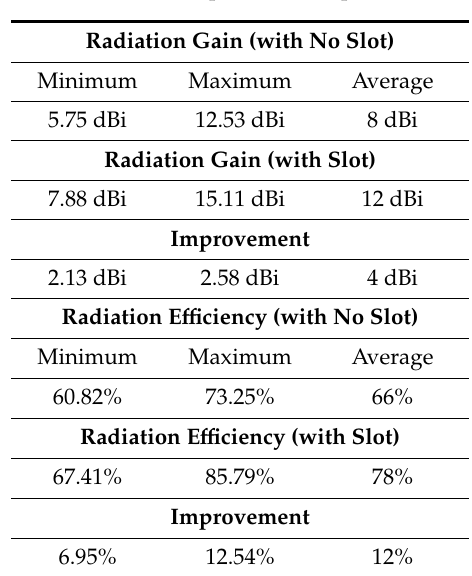
Figure 5. Radiation efficiency response for both cases “before applying” the slots and “after applying” the slots using two different commercially available 3D full wave electromagnetics simulation tools (CST Microwave Studio ® and HFSS™). Table 2. Radiation performance